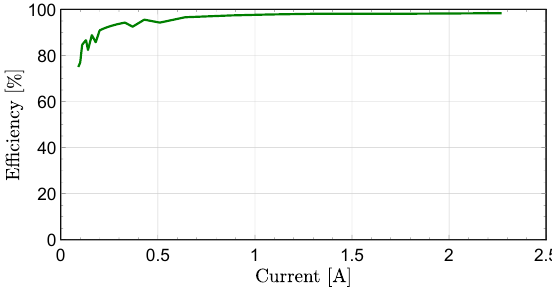
Figure 20. The efficiency Vs output current of the proposed